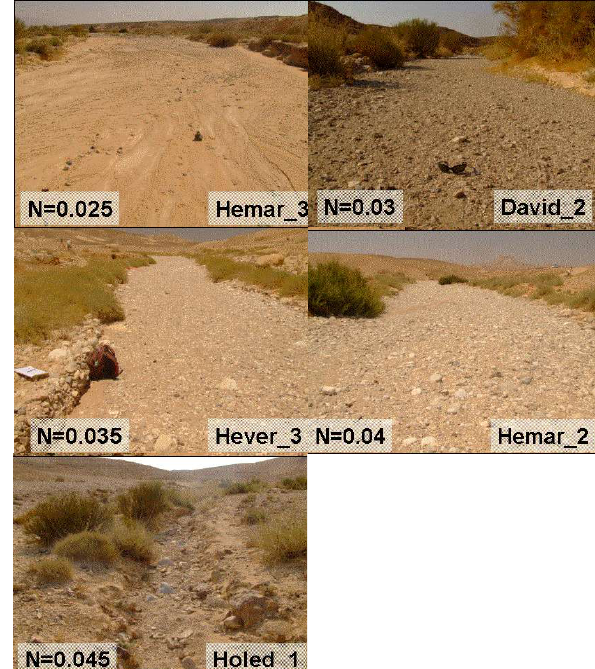
Fig. 4. Examples for Manning coefficients ( N ) in typical cross sec- Figure 4. Examples for Manning coefficients (N) in typical cross sections from the study area. tions from the study area. See Tables A1 and A2 for the properties See Appendix A for the properties of these cross section locations. of these cross section